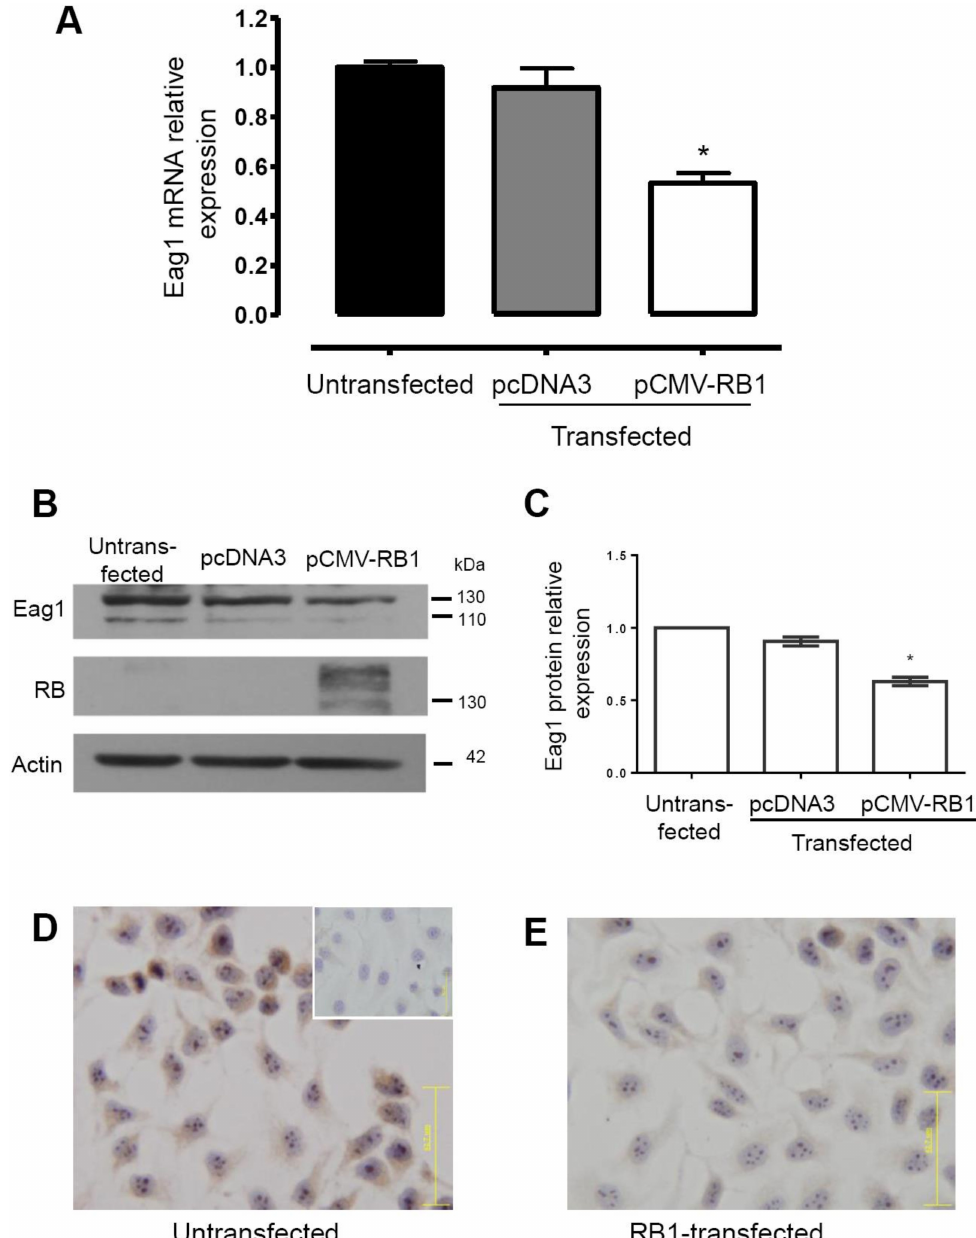
Figure 1. Retinoblastoma protein (pRb) down-regulates Ether à -go-go-1 (Eag1) expression in HeLa cells. Relative Eag1 mRNA expression assessed using real-time PCR revealed a significant decrease of Eag1 mRNA expression in cells transfected with RB1 . The empty vector (pcDNA3) did not modify Eag1 expression ( A ). Western blot experiments showed that pRb transfected cells display lower Eag1 protein levels and higher pRb expression ( B ). Quantitative analysis of both Eag1 bands, relative to actin expression ( C ). Accordingly, untransfected cells displayed clear Eag1 protein expression in immunochemistry assays (brown immunostaining) in the cytoplasm ( D ), while RB1 -transfected cells showed decreased Eag1 protein expression ( E ). No signal was observed in the absence of the primary antibody (insert, (D)). The graphs show mean ± s.d., n = 3 in (A) and n = 5 in (C). * p < 0.05 versus untransfected and pcDNA3. Magnification: 400 ×